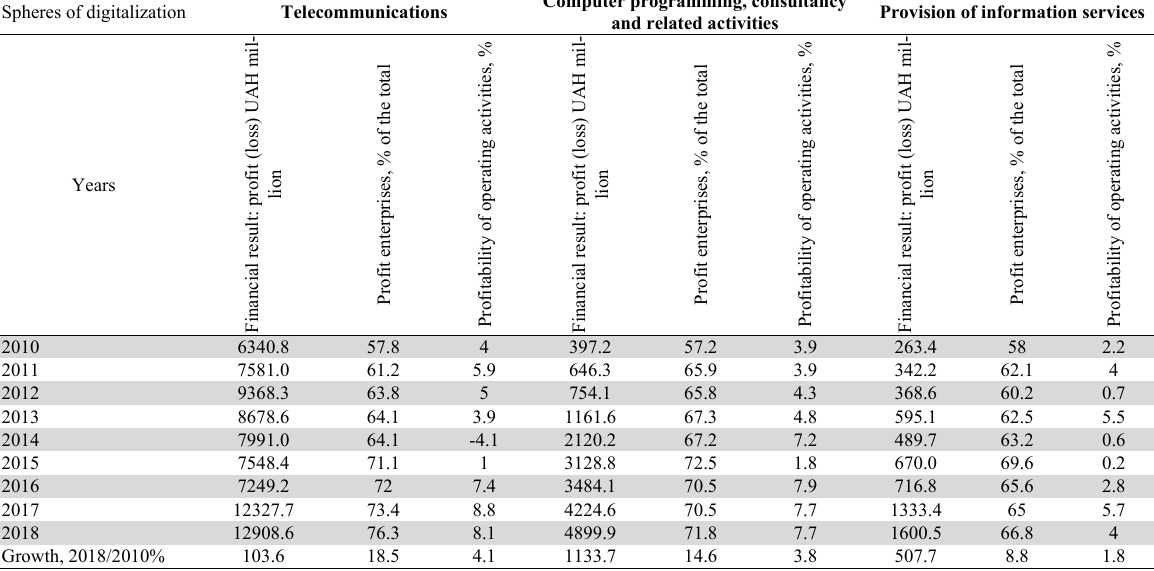
Dynamics of financial results of enterprises in the field of information and telecommunications in Ukraine Spheres of